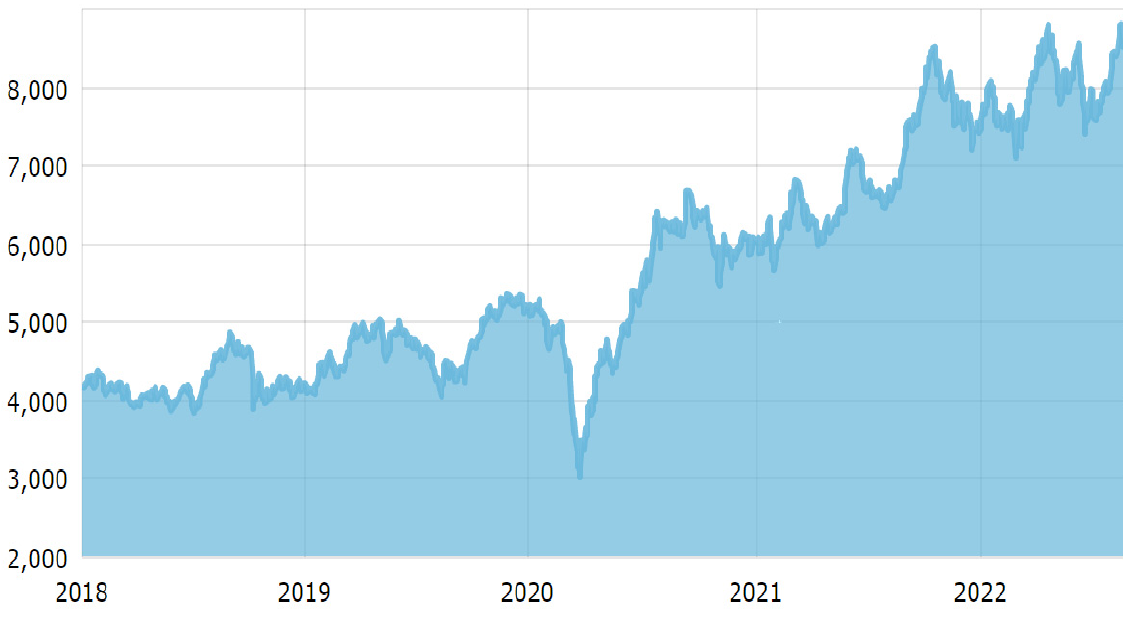
Figure 1. S&P BSE Energy Index Performance 1 January 2018–24 August 2022. Source: https://www.bseindia.com/sensex/code/90 (accessed on 24 August 2022) [17].